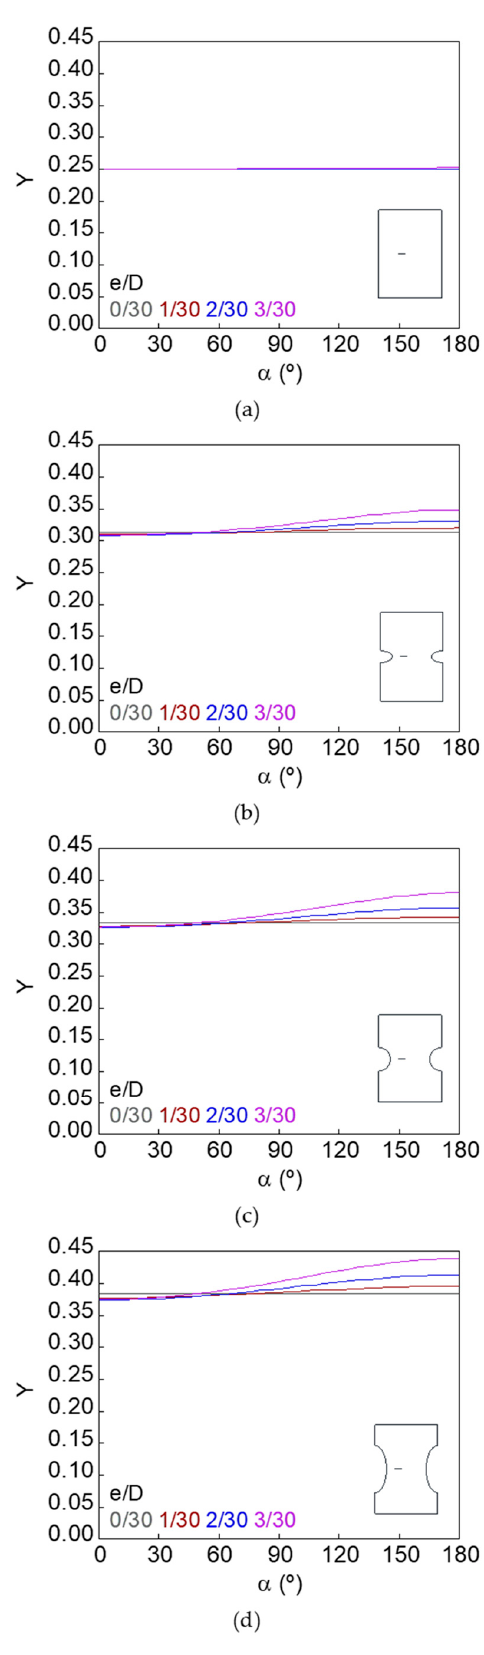
Figure 10. Dimensionless SIF along the crack front, d / D = 9/30: ( a ) smooth bar; ( b ) sharp notched bar; ( c ) circular notched bar; ( d ) blunt notched bar.